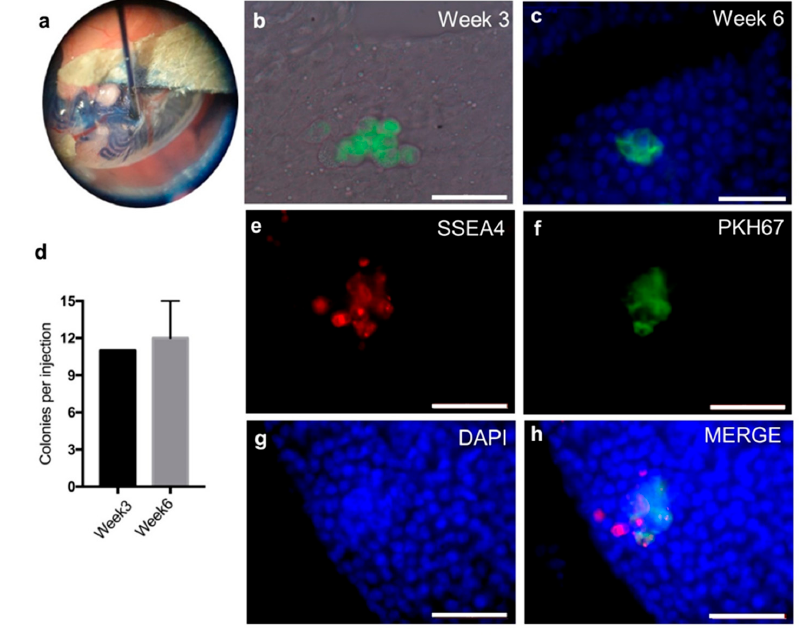
Figure 7. Xenotransplantation of the human cells into busulfan treated nude mice. ( a ) Demonstration of successful transplantation of human SSC-like cells into murine seminiferous tubules using trypan blue. ( b ) PKH67 (a green fluorescent cell linker) pre-labelled cells forming colonies in recipient testis merged with bright channel three weeks after transplantation. ( c ) PKH67 pre-labelled cells forming colonies in recipient testis merged with DAPI staining six weeks after transplantation. ( d ) Mean number with standard deviation of colonies formed numbers in recipient mouse testis. Three weeks after transplantation ( n = 1) and six weeks after transplantation ( n = 3). ( e–h ): Whole mount immunofluorescent analysis of mouse testis six weeks after transplantation by SSC marker, stage-specific embryonic antigen-4 (SSEA4; red) and DNA visualization by DAPI staining (blue) ( e ) SSEA4; ( f ) PKH67; ( g ) DAPI and ( h ) merged pictures from previous three channels. Scale bar: 50 µ